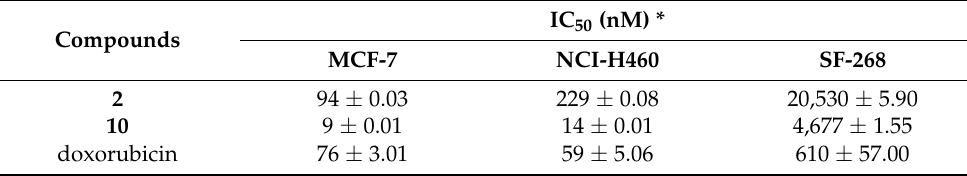
Table 4. Anticancer activity of bufadienolides isolated from R. alata .